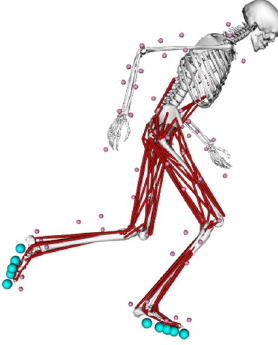
Figure 2. The three-dimensional musculoskeletal model used in this study (adapted from Hamner, et al. 26 ). The human skeleton was modelled with 20 rigid segments: a pelvis, trunk (torso plus head), right and left lower- limbs (thigh, shank, upper rearfoot, lower rearfoot and forefoot) and upper-limbs (upper-arm, lateral forearm, medial forearm and hand). The DOFs of model were as follows: × 6 pelvis-to-ground, × 7 per lower-limb (× 3 hip, × 1 knee, × 1 ankle, × 1 subtalar and × 1 MTP), × 3 back, and × 7 per upper-limb (× 3 shoulder, × 2 elbow and × 2 wrist). The virtual model markers and smooth Hunt–Crossley contact spheres are denoted by pink and turquoise spheres, respectively. This same model was also used to perform the inverse kinematics and